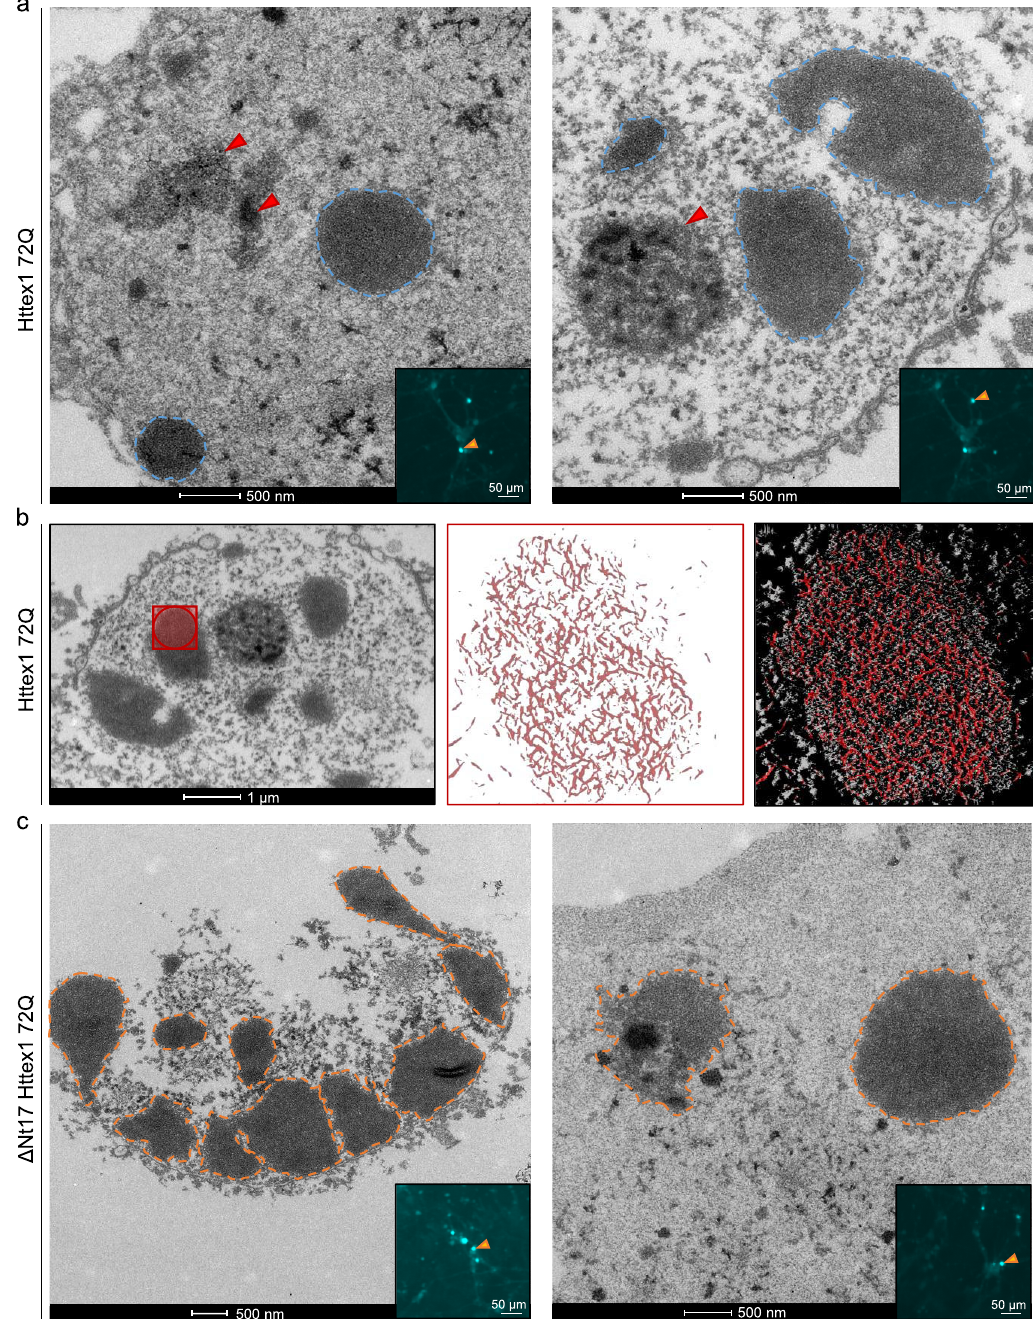
Fig. 6 Ultrastructural analysis of the nuclear Httex1 72Q inclusions formed in primary cortical neurons shows granular and fi lamentous structures by CLEM and Tomography. a Representative electron micrographs of Httex1 72Q inclusions formed 7 days after lentiviral transduction in mouse cortical primary neurons. Blue dashed lines represent the inclusions, and the red arrowheads the nucleolus. Scale bars = 500 nm for the EM images and 50 μ m for the fl uorescent image (inset). b Electron micrograph and corresponding tomogram (selected area in red) of a neuronal Httex1 72Q inclusion in panel a. Segmentation of the tomogram reveals the presence of a multitude of fi laments. c Representative electron micrographs of Δ Nt17 Httex1 72Q inclusions formed seven days after lentiviral transduction in mouse cortical primary neurons. Orange dashed lines represent the inclusions, and the red arrowheads the nucleolus. Scale bars = 500 nm for the EM images and 50 μ m for the fl uorescent image